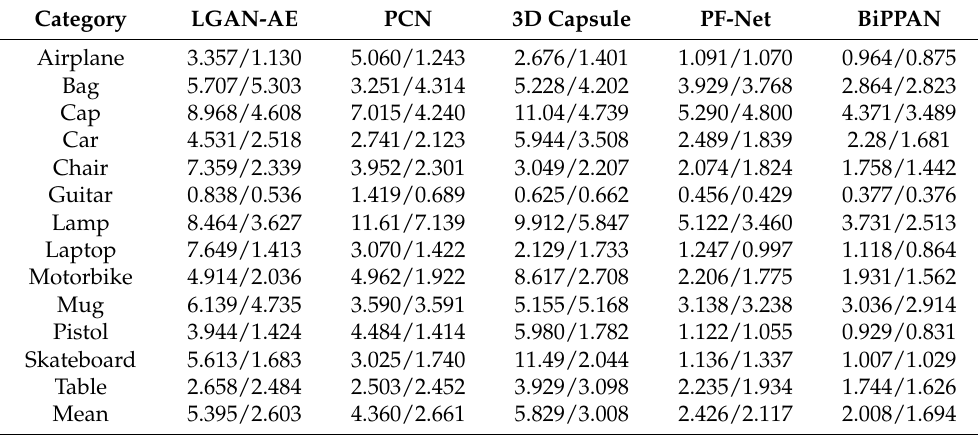
Table 1. Results of a comparison between our method and most advanced methods on the ShapeNet- 13 dataset. The numbers in pairs are Pred → GT and GT → Pred Chamfer Distance × 10 3 (lower is better).